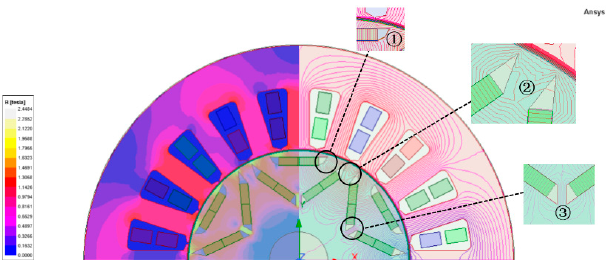
Figure 7. No-load magnetic field distribution cloud map in ∇ shape rotor